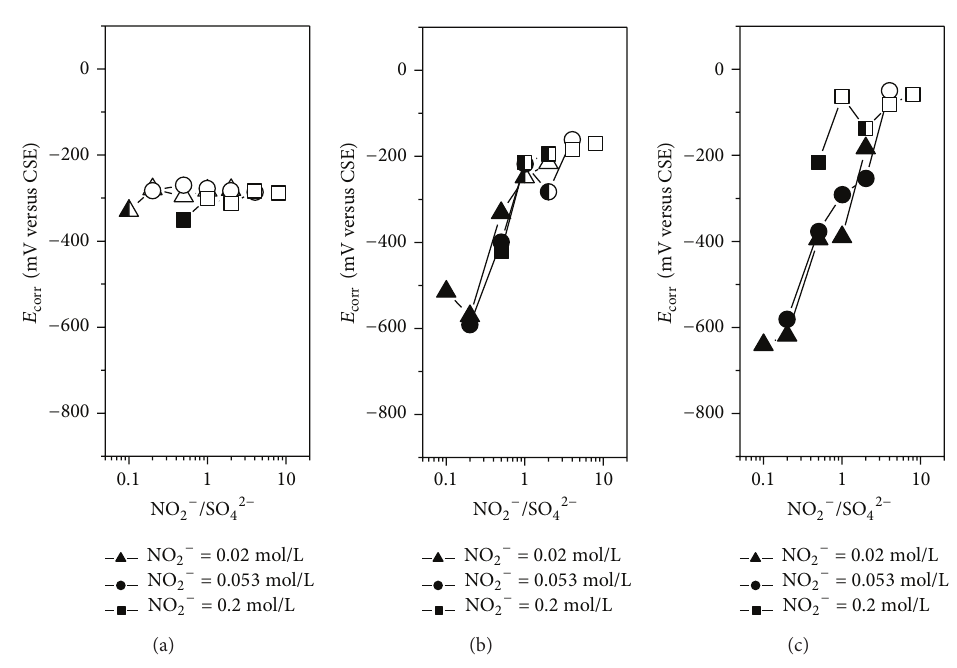
Figure 7: Effect of NO 2 − on 𝐸 versus log(NO 2 − /SO 4 2− ) curves. (a) pH = 12.6, (b) pH = 10.3, (c) pH = corr